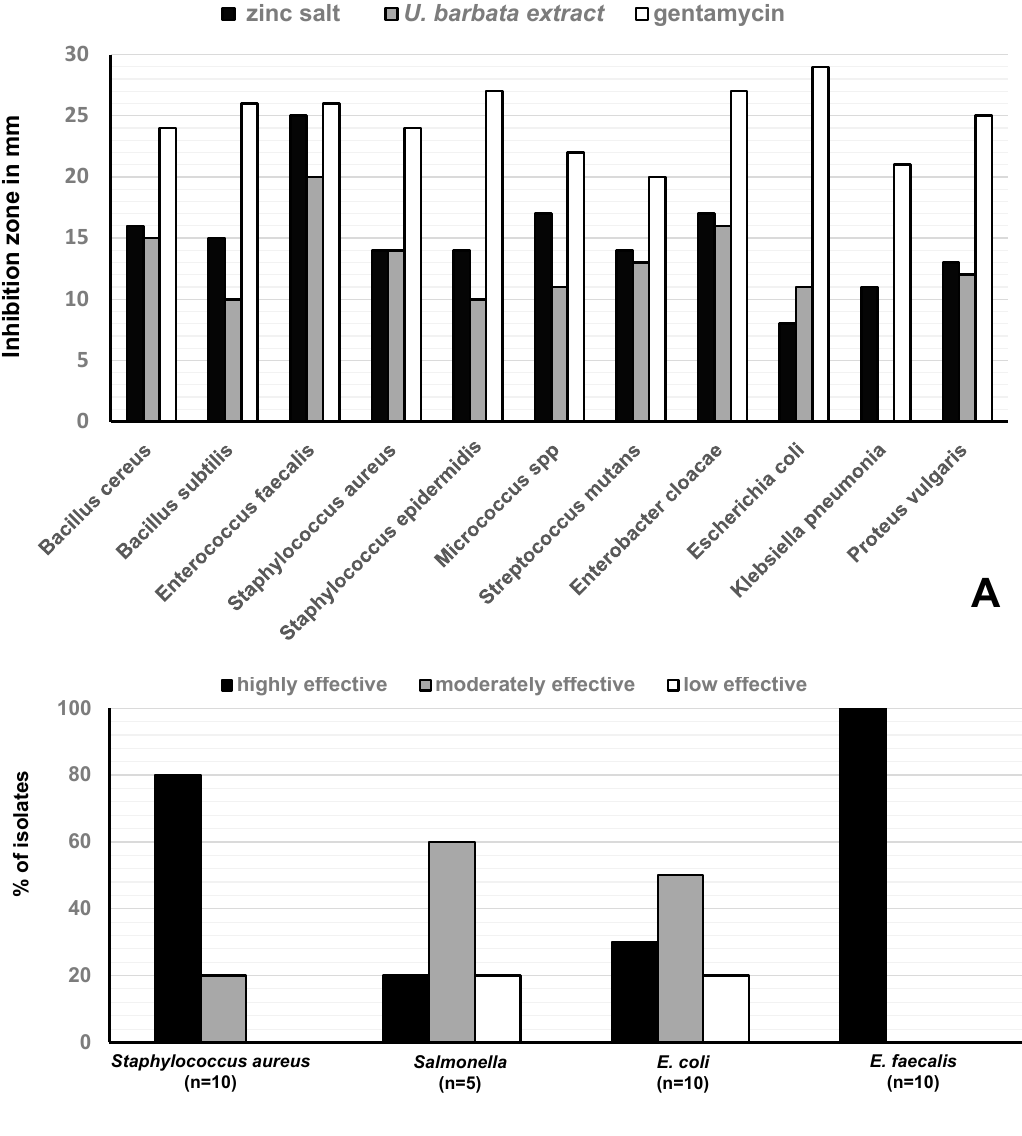
Figure 4. Antimicrobial activity of U. barbata preparations. ( A ) Size of the inhibition zone of the sunflower-oil U. barbata extract and its zinc salt on Gram-positive and Gram-negative reference strains; ( B ) In vitro effect of the salt on S. aureus ( n = 10), Salmonella spp ( n = 5), E. coli ( n = 10), and E. faecalis ( n = 10) strains isolated from chickens. Not effective (very small inhibition zone) ≤ 8 mm, low effective (small inhibition zone) = 8 – 13, moderately effective (medium inhibition zone) = 14 – 19 mm, and highly effective (large inhibition zone) ≥ 20 mm. Sunflower oil was used as negative control and did not cause a zone of inhibition.